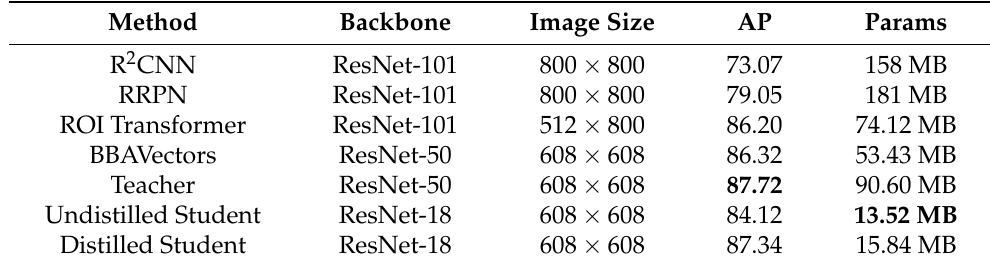
Table 1. Overall performance evaluation of different methods on HRSC2016 datasets. Bold numbers in the table mean the best